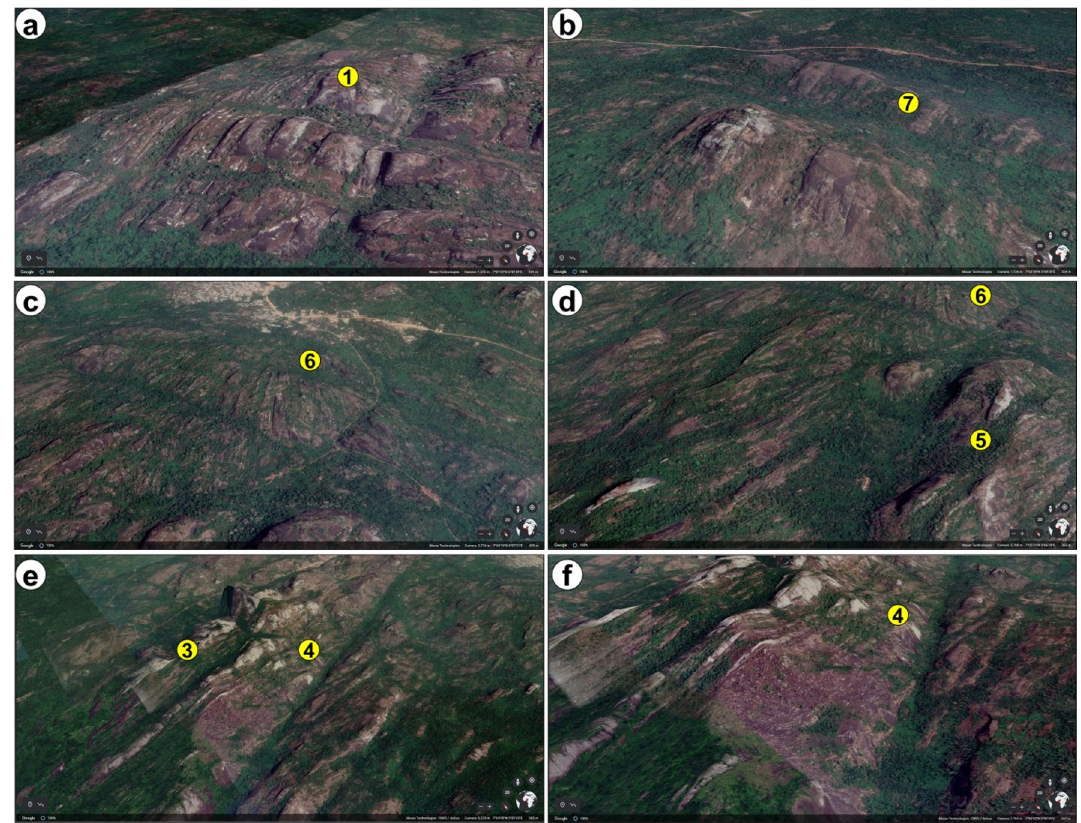
Figure 11. Uninterpreted and virtually realized 3D images of points 1–7. Maps data: Google Earth, Maxar Technologies and